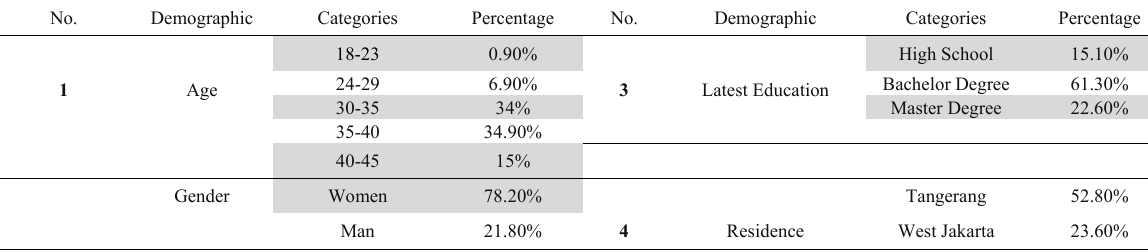
Demographic characteristics of survey